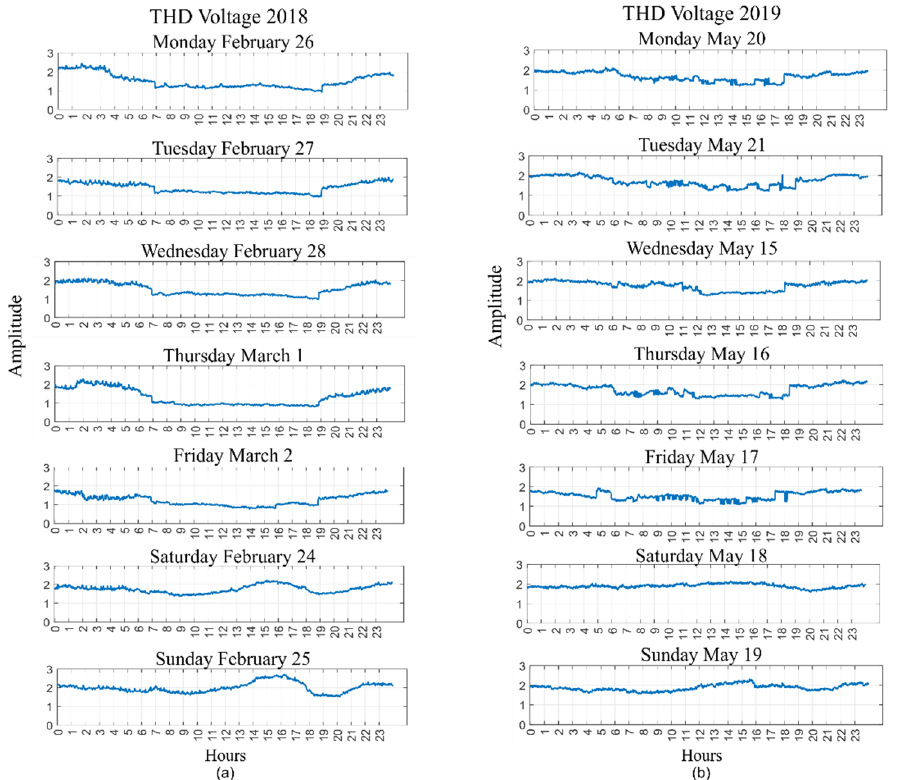
Figure 9. Voltage THD for the: ( a ) week from 2018, ( b ) week from 2019.